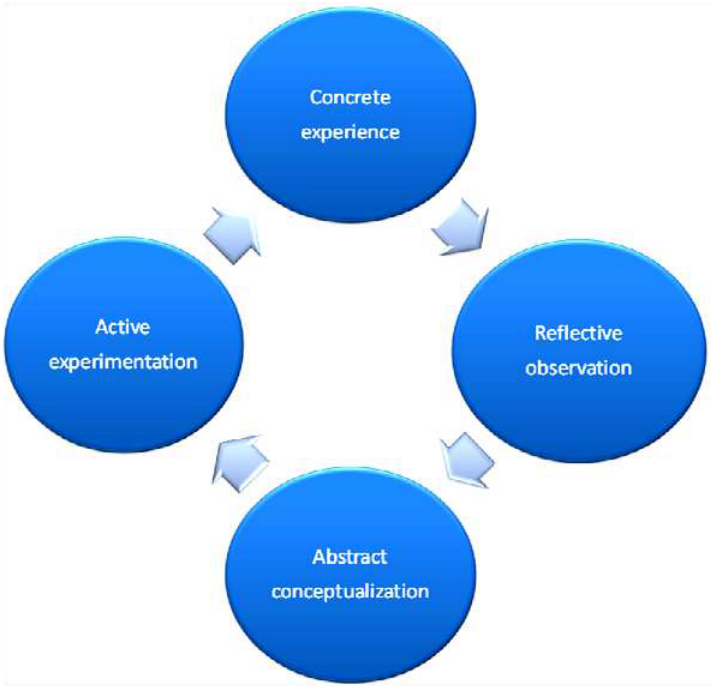
Fig. 2. Kolb’s cycle of experiential learning